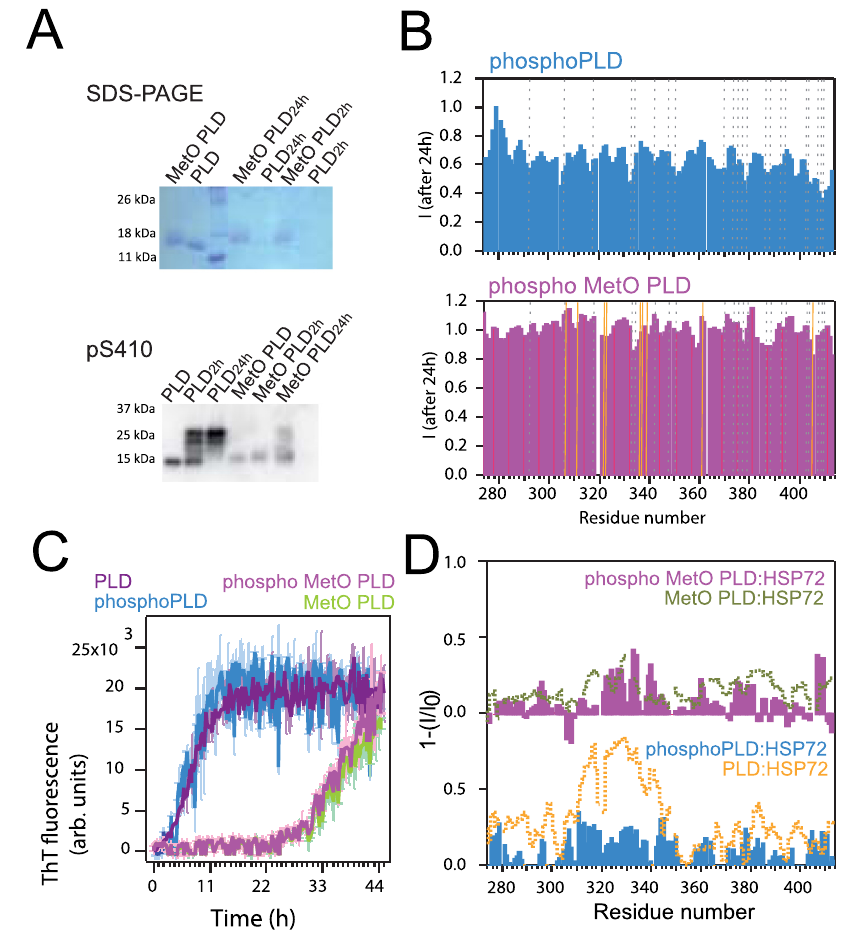
Fig. 5 | MetO impairs CK1 δ phosphorylation. A Western blot immunoblotting results for the phosphorylation of the PLD using pS410 (bottom) antibody. CK1 δ incubation times are indicated. Band at 14kDa corresponds to unphosphorylated PLD, and phosphorylation is revealed as an increase in the molecular weight. On top,thesamesamplesaresubjectedtoSDS-PAGE,forcomparison.Phosphorylated PLD is undetected in the gel due to aggregation. MetO samples are noticeably detained during migration in the gel. B NMR signal intensity decay plots after 24h of incubation at 25°C for 40 μ M phosphoPLD (top) and phospho MetO PLD